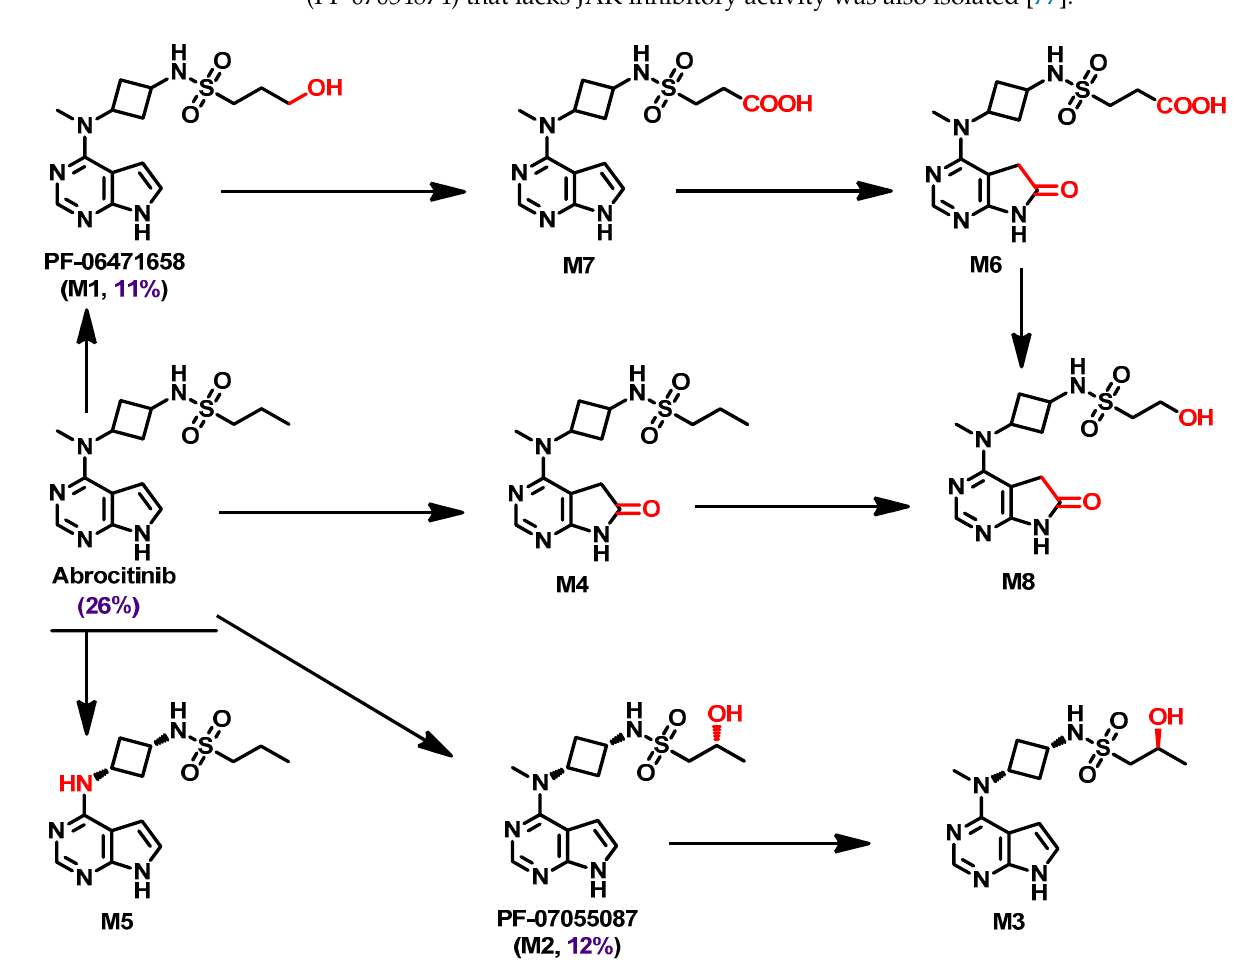
Figure 15. Proposed metabolic pathways and metabolites of abrocitinib.